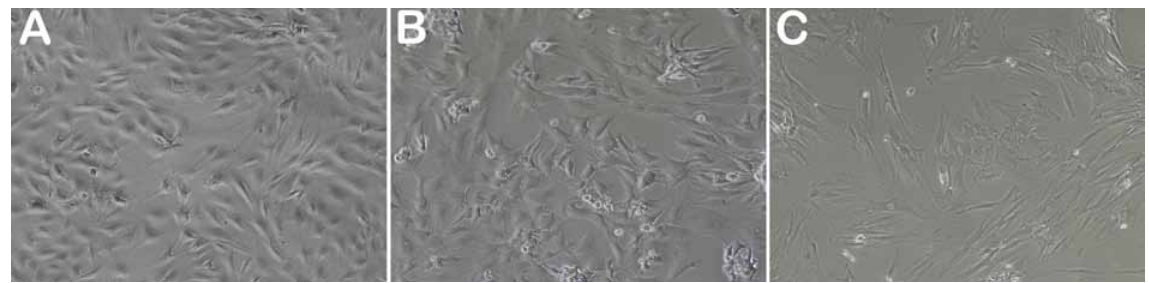
Figure 2. Cell morphology. Fibrochondrocytes (A), articular chondrocytes (B) and osteoblasts (C) after three day culture on BioFlex® culture plates.